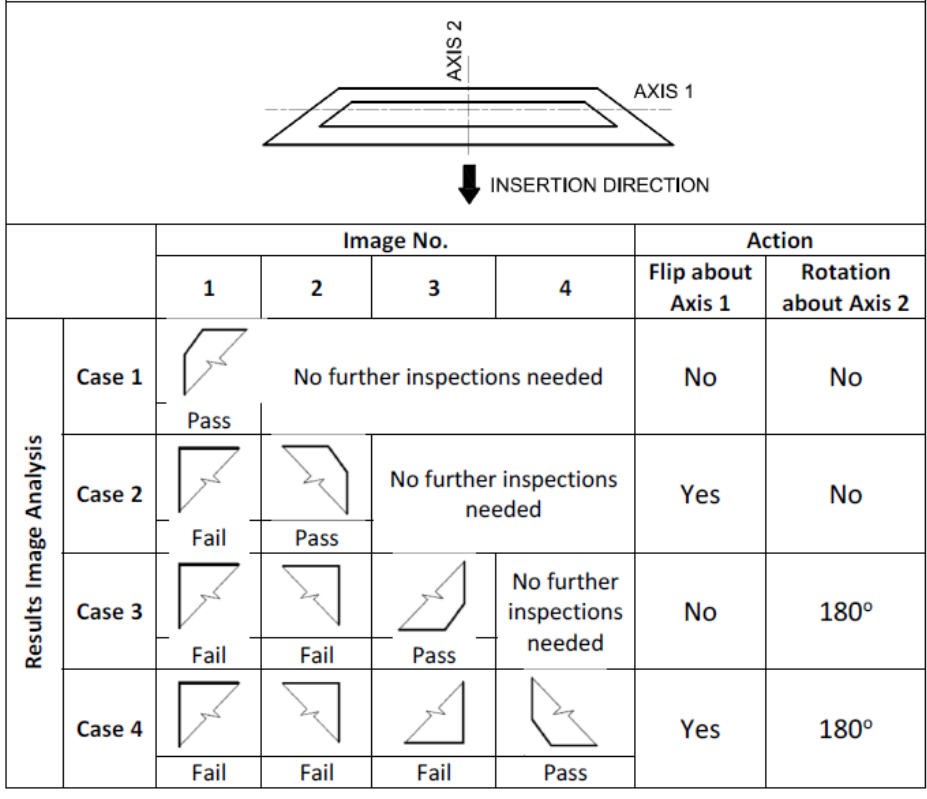
Figure 8. Image analysis result showing identification of the chamfered gasket corner in the first position.